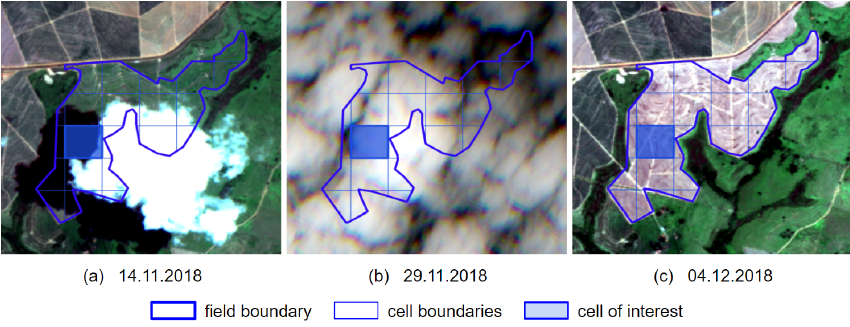
Figure 13. ( a – c ) Example of the cloudiness effect during the harvest period (November).